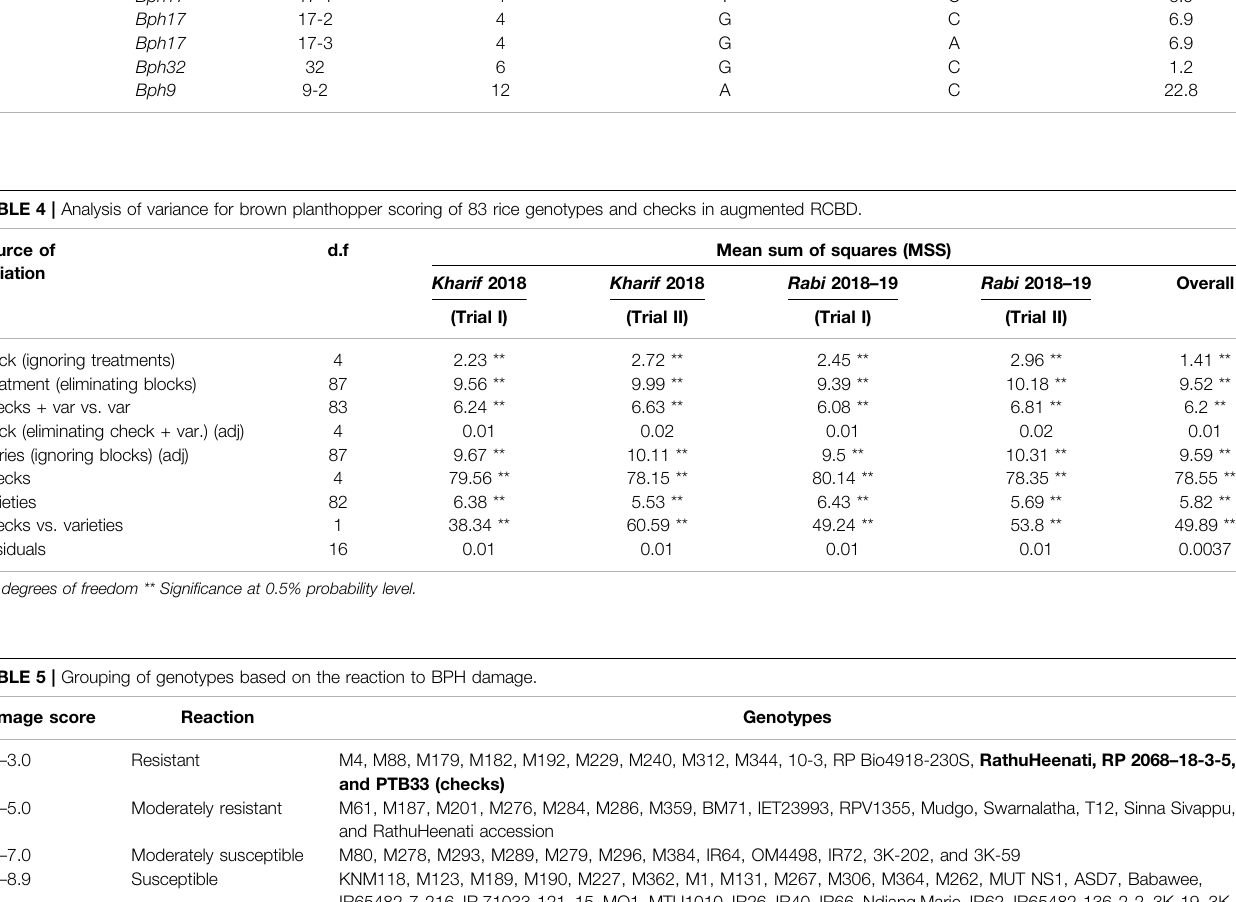
TABLE 3 | List of reported functional SNPs validated in the study. S. No.